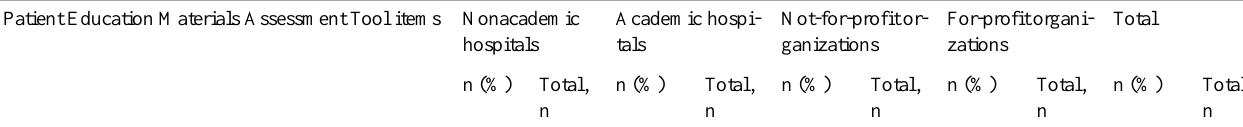
Table 4. Patient Education Materials Assessment Tool for understandability and actionability and performance of websites per website category.